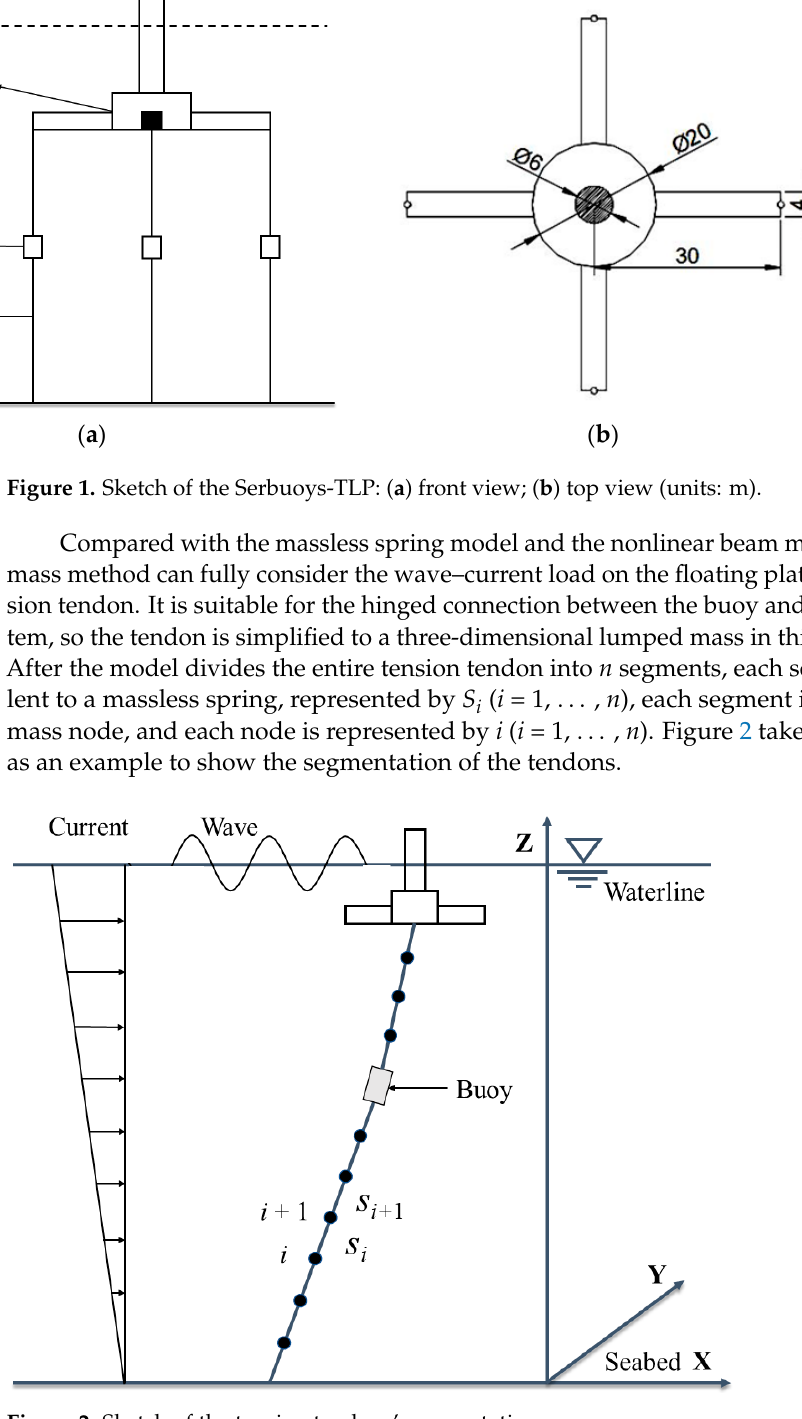
Figure 2. Sketch of the tension tendons’ segmentation. The weight and external load of each segmented element of the tension tendon are equivalently concentrated at the nodes at the ends of the element. The forces on the nodes include the tension of the adjacent segments, the gravity and buoyancy of the segments, and the fluid force. If a buoy is connected between the tension tendons, the gravity, buoyancy, and fluid force on the buoy should also be considered for the corresponding nodes